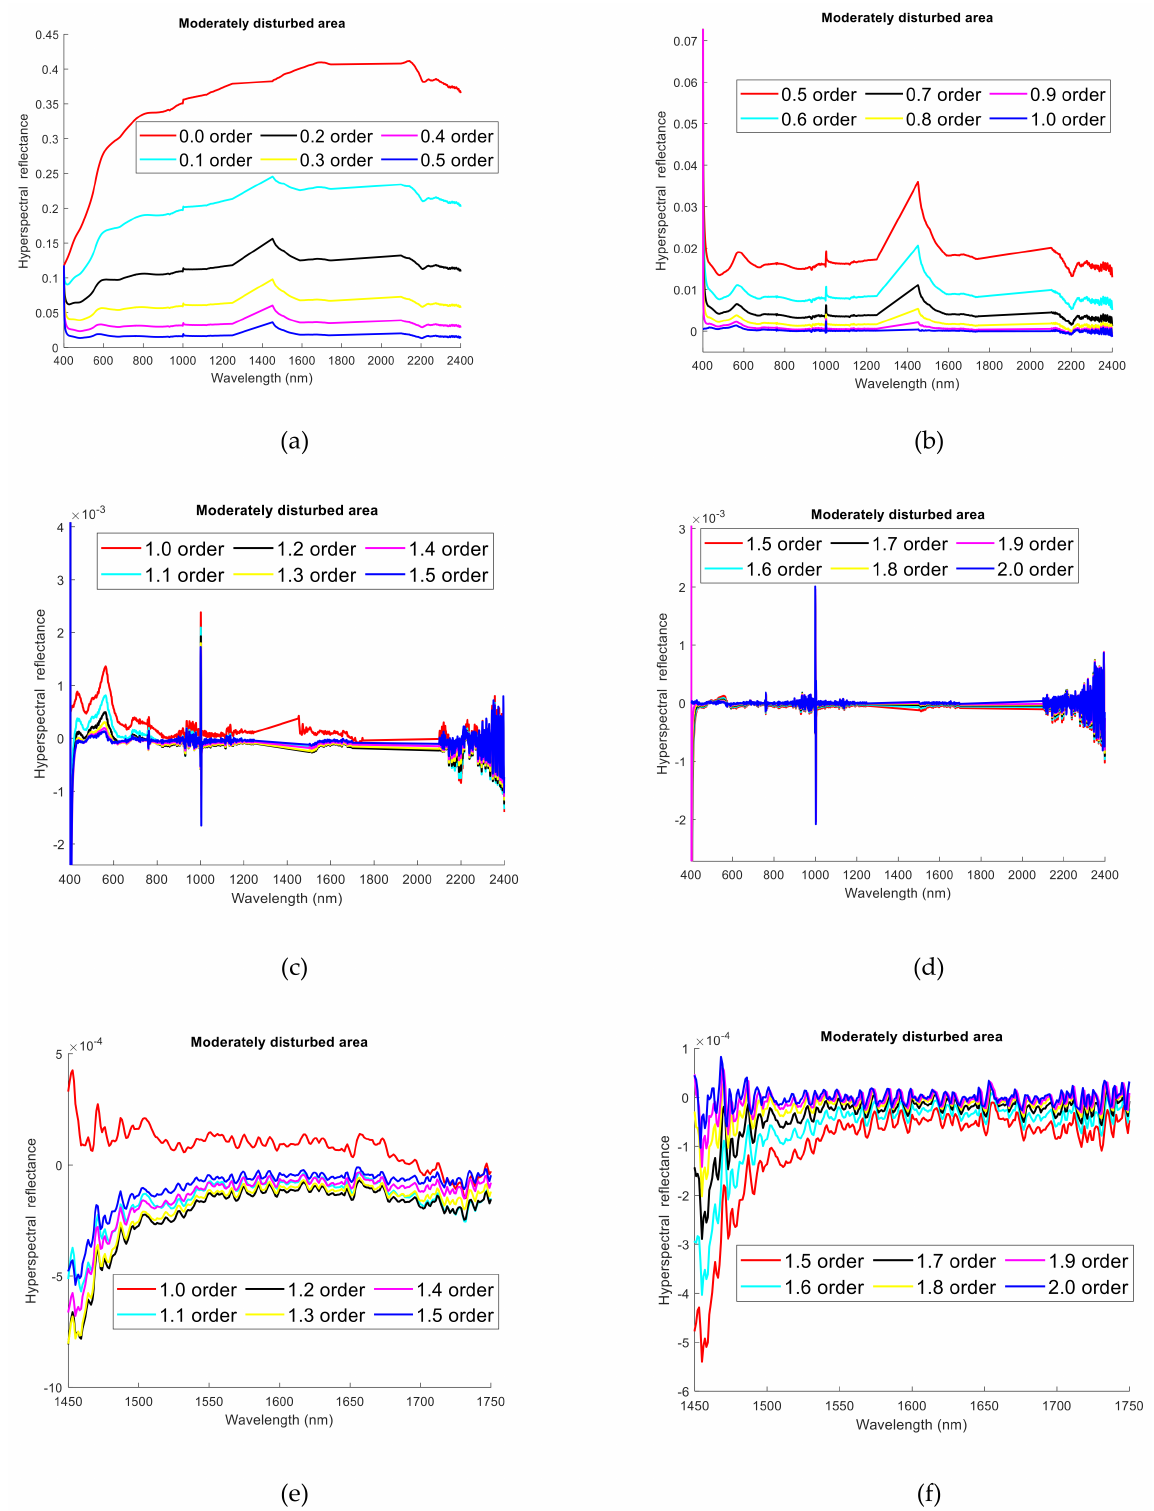
Figure 3. The reflectance curve of the soil original hyperspectral calculated by FOD in the moderately disturbed area: ( a ) 0.0-order to 0.5-order; ( b ) 0.5-order to 1.0-order; ( c ) 1.0-order to 1.5-order; ( d ) 1.5-order to 2.0-order; ( e ) 1.0-order to 1.5-order of local amplification band; ( f ) 1.5-order to 2.0-order of local amplification